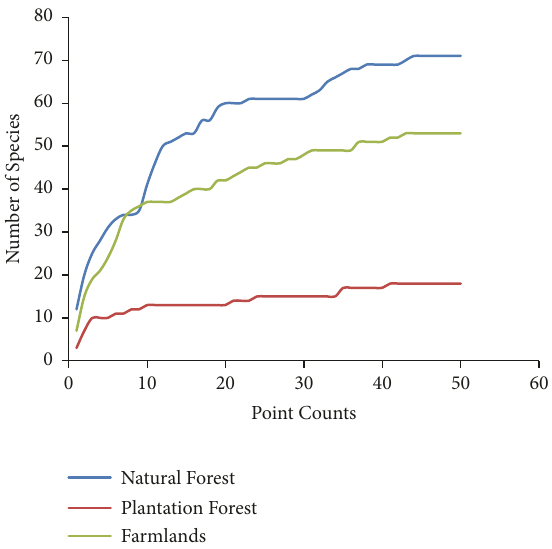
Figure 2: Species accumulation rates for birds at Nanyuki Forest Block, Western Mount Kenya: March-May and August-September 2014.